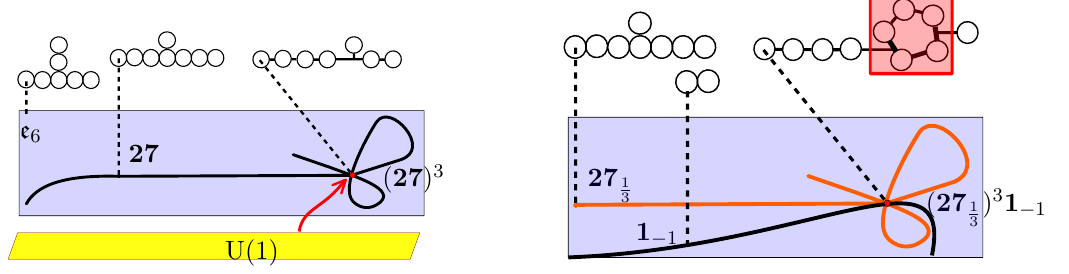
Figure 4 . Two depictions of the e 6 divisor in blue and its fiber structure in the four-fold X 4 , 0 and X 4 ,a . In X 4 , 0 the 27 3 Yukawa point leads to a (reduced) E 8 fiber bouquet. Upon adding a u 1 brane the E 8 fiber becomes non-flat fiber and leads to a four-point